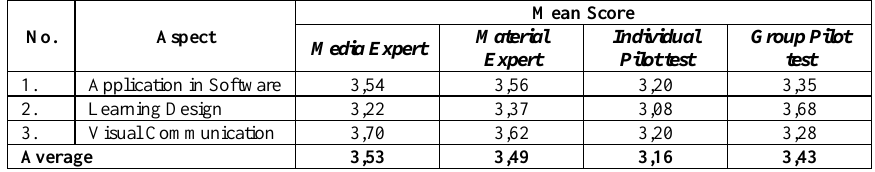
Table 1. Android-Based Teaching Material Validation